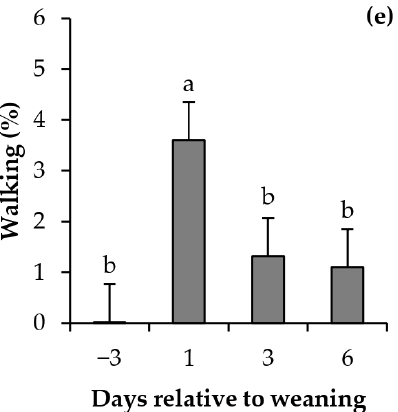
Figure 6. Grazing ( a ), idle time ( b ), trough time ( c ), pacing ( d ), and walking ( e ) in Nellore cows under grazing according to the days relative to weaning. Days with different superscripts differ from each other ( p < 0.05). Table 3. E ff ect of parity on behavior observation in Nellore cows at abrupt weaning.